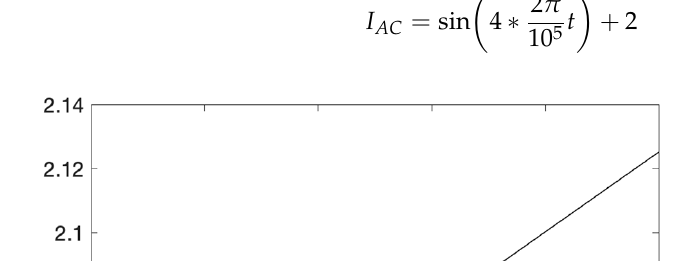
Figure 8. The estimated voltage from the AM4 - AB4 method versus the exact voltage plotted when the current is also varying. The MAE and RMSE were obtained to be 0.2796 and 0.0582, respectively. Though these results are good approximations, they show that more variables must be added to the original LIF model to manage more complex inputs and move closer to modeling the actual neuron behavior. Since these methods are based on the last or multiple last calculated values, the error aggregates and grows if the preceding value is not accurate. Therefore, it needs to be en- sured that the error at each step is minimized, which gives room for adaptive techniques, which are a few techniques that can be explored in these methods. In one of their studies, Shelley and Tao studied the effect of the time step of RK2 and RK4 on a LIF model with spikes [16]. They found that to achieve a six-digit accuracy, a time step of 0.5 (cid:3400) 10 (cid:2879)(cid:2871) 𝑠 for RK4 and 10 (cid:2879)(cid:2873) 𝑠 for RK2 was required. As for the choices